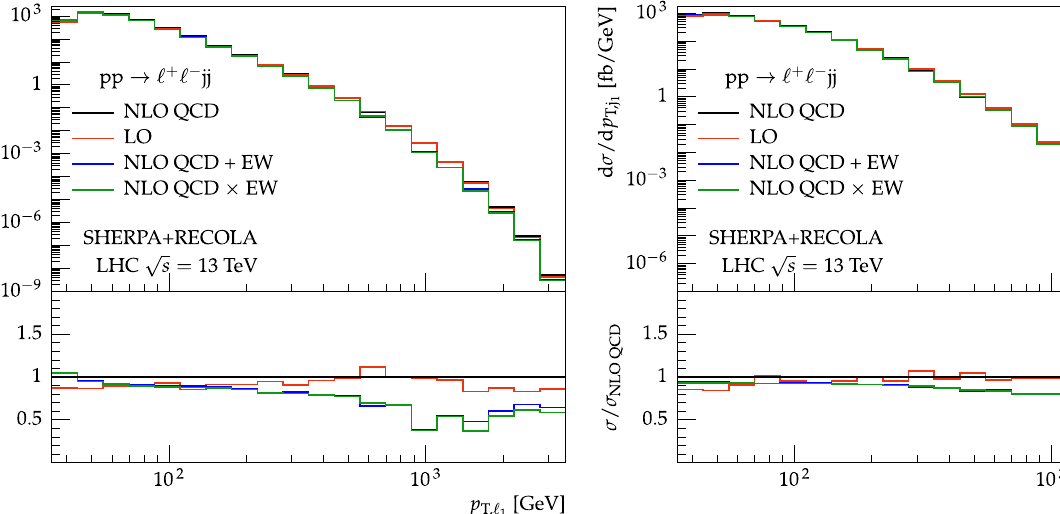
Fig. 8 Differential distributions at 13TeV for pp → (cid:6) + (cid:6) − jj at the LHC. The left-hand plot shows the p T of the hardest lepton and the right-hand plot the p T of the hardest jet. The LO and NLO QCD dis- tributions are plotted along with both the additive (NLO QCD + EW)